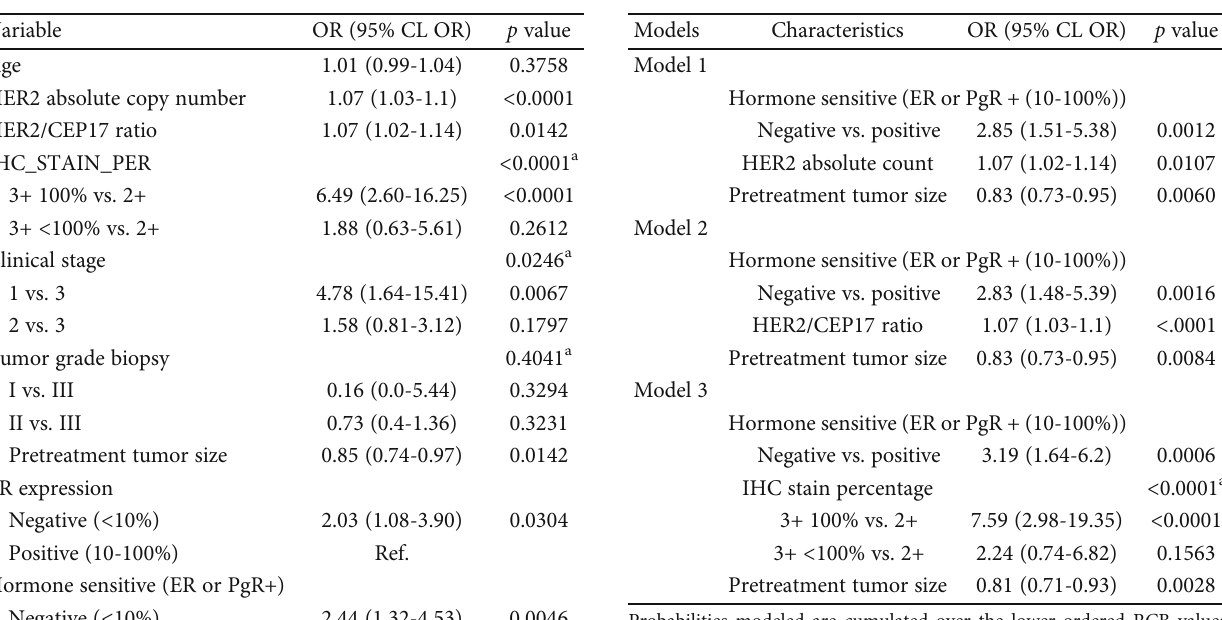
Table 4: Univariate predictors of treatment response for HER2+ breast cancer patients receiving neoadjuvant chemotherapy.